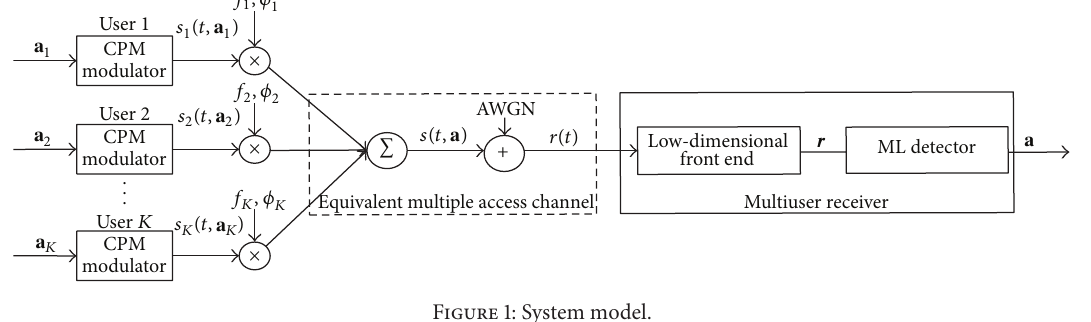
Figure 1: System